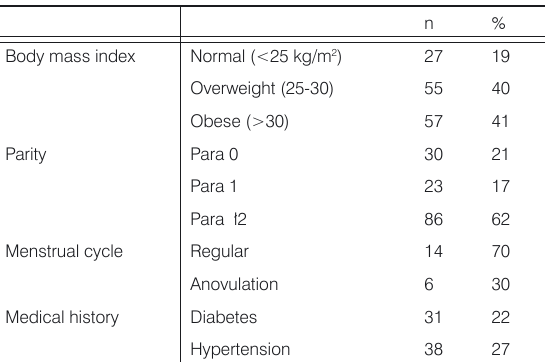
Table 2. Clinical features of